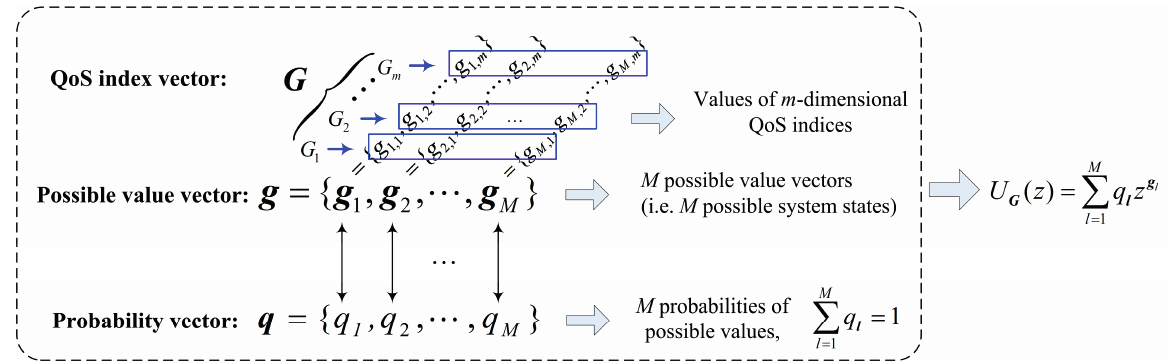
Figure 3. Relationships between G , g and q in the